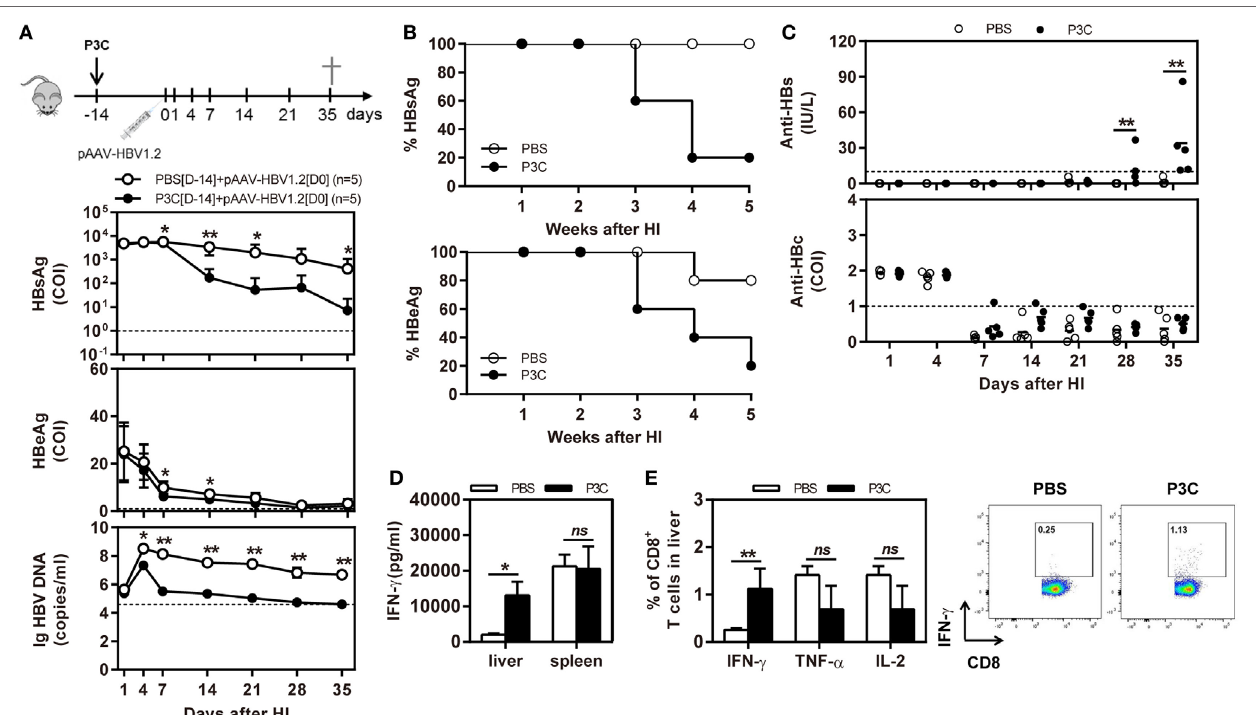
FigUre 5 | Pre-treatment with P3C accelerates hepatitis B virus (HBV) clearance in the mouse model for persistent HBV replication and promotes intrahepatic HBV-specific T-cell response. C57BL/6 mice were pretreated once with 20 µg of P3C or phosphate-buffered saline administered by intravenous (IV) injection at day 14 (D-14) before hydrodynamic injection (HI) with plasmid pAAV-HBV1.2. (a) Serological markers of HBV infection HBsAg, Hepatitis B e antigen (HBeAg), and HBV DNA were assayed at the indicated time points. (B) Positivity for HBsAg or HBeAg was defined as ≥ 1*. (c) The serum levels of anti-HBs and anti-HBc antibodies were detected at the indicated time points. (D,e) Lymphocytes were isolated from the mouse liver and spleen at day 35 after HI. (D) The lymphocytes were stimulated with peptide Cor 93–100 for 48 h. Interferon gamma (IFN- γ ) production was measured by ELISA. (e) The functionality of intrahepatic HBV-specific CD8 + T cells was determined by intracellular cytokine staining after ex vivo stimulation with peptide Cor 93–100 for 5 h. The percentage of HBV-specific IFN- γ + of CD8 + T cells was detected by flow cytometry. Five mice were analyzed per group, and the experiments were repeated at least once. Data were analyzed using an unpaired Student’s t test. Statistically significant differences between the groups are indicated as * P < 0.05 and ** P <